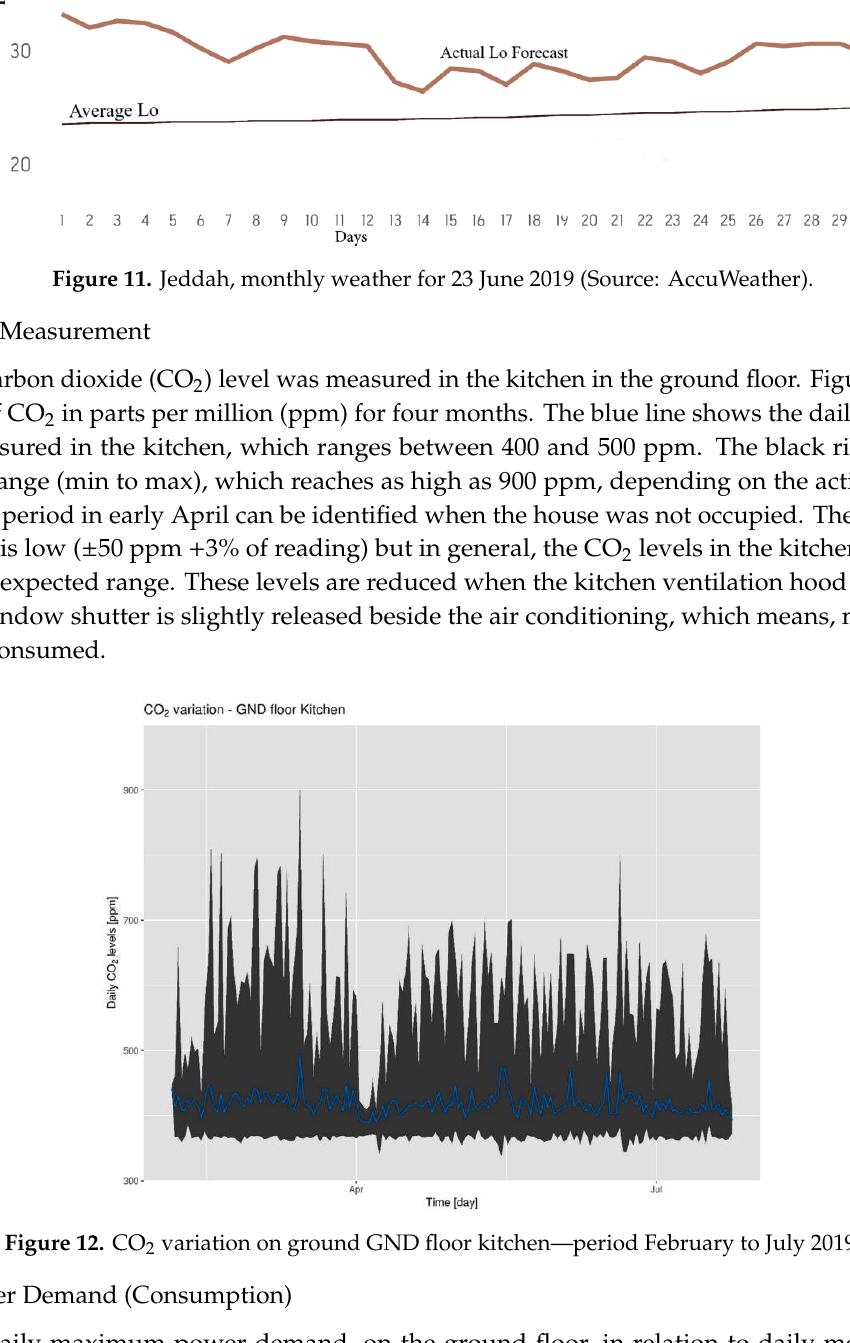
Figure 10. Temperature variation during the day with the maximum ambient temperature on 21 June 2019 in the measurement period from February to July 2019.